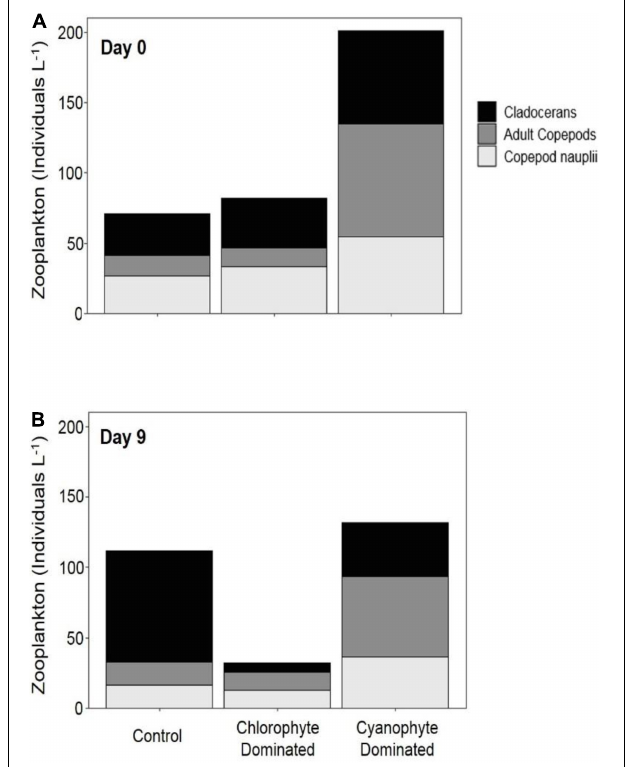
FIGURE 4 | Zooplankton abundance in mesocosm tanks. Abundance was measured on day 0 (A) and day 9 (B) for control tanks, tanks dominated by chlorophytes at the beginning of the experiment, and tanks dominated by cyanophytes at the beginning of the